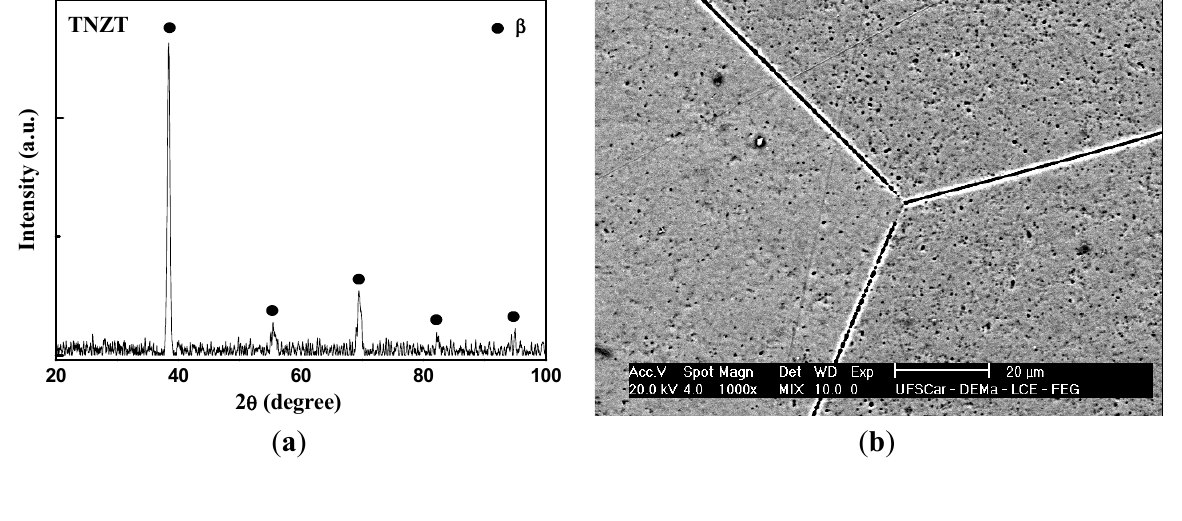
Figure 1. ( a ) XRD patterns; and ( b ) SEM microstructures of the TNZT alloy after homogenization heat treatment for 6 h at 1273 K, followed by furnace